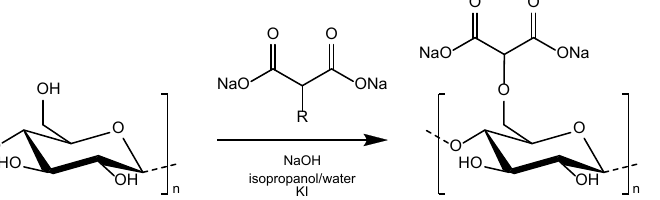
Figure 1. Schematic representation of the synthesis of DCMC. Reproduced from Gago, Chagas and Ferreira [30] (CC BY 4.0).